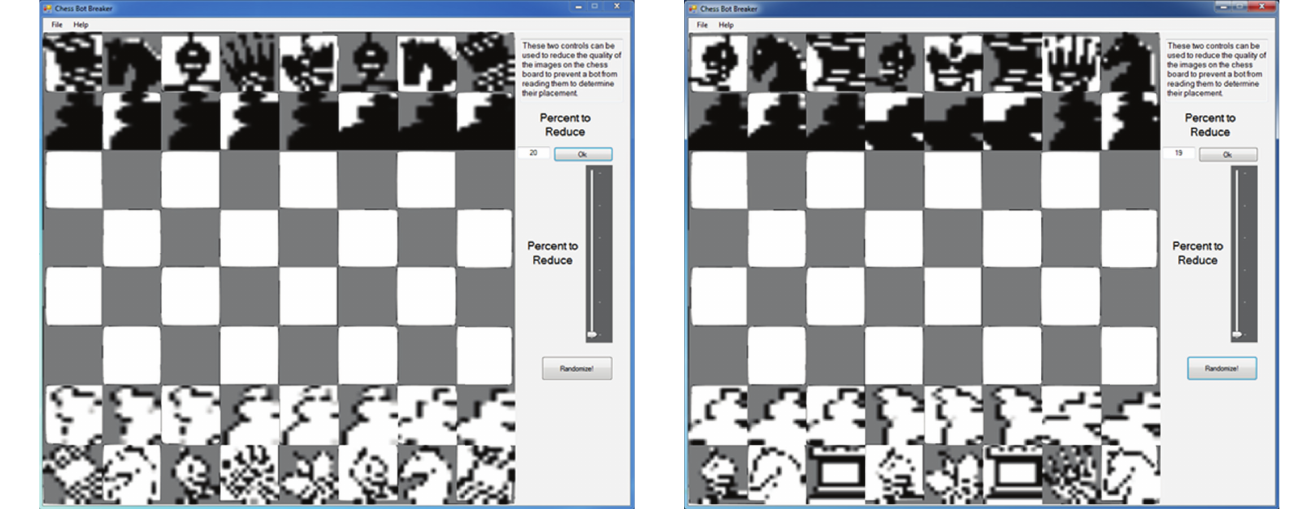
Figure 3: Distortion using the text box. Figure 4: Fischer Random